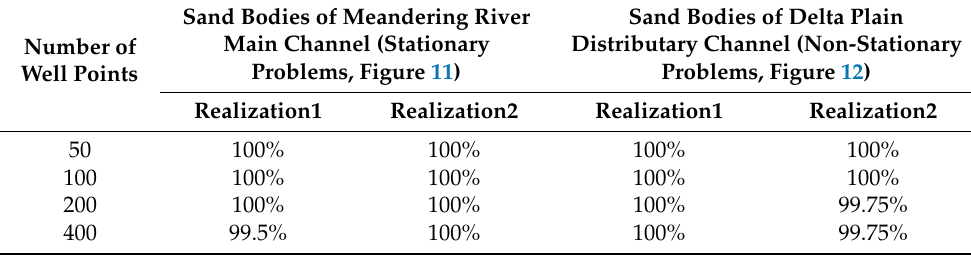
Table 1. Well point coincidence rate of conditional modeling with different number of well point hard data